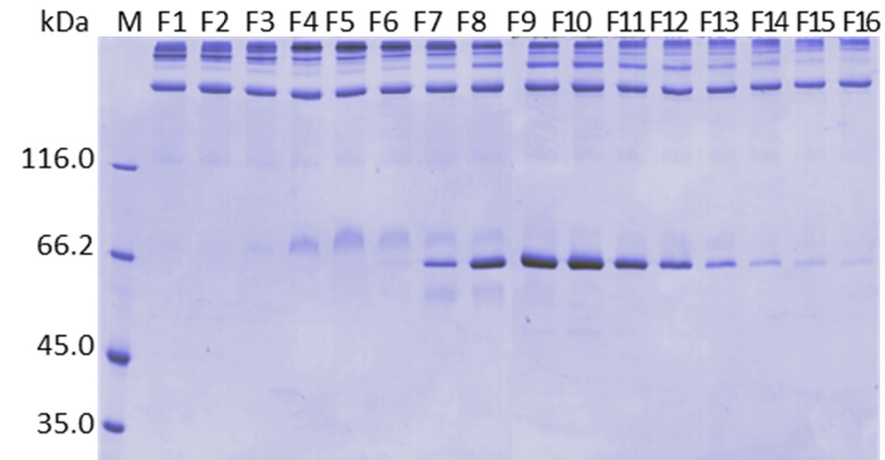
Figure 7. SDS ‐ PAGE 7.5% analysis under non ‐ reducing conditions of the purification of plasma on ANX Sepharose FF with CaCl 2 5 to 25 mM linear gradient in 25 mM citrate, 200 mM NaCl, pH 6.0 buffer.